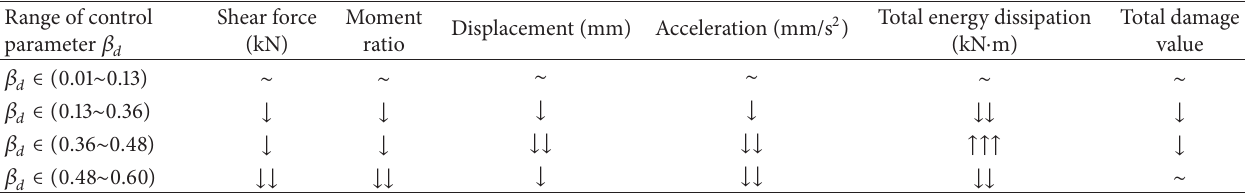
Table 7: Analytical table of the influence of varying ductility-based strength degradation parameter 𝛽 𝑑 on structural responses and damage. Range of control